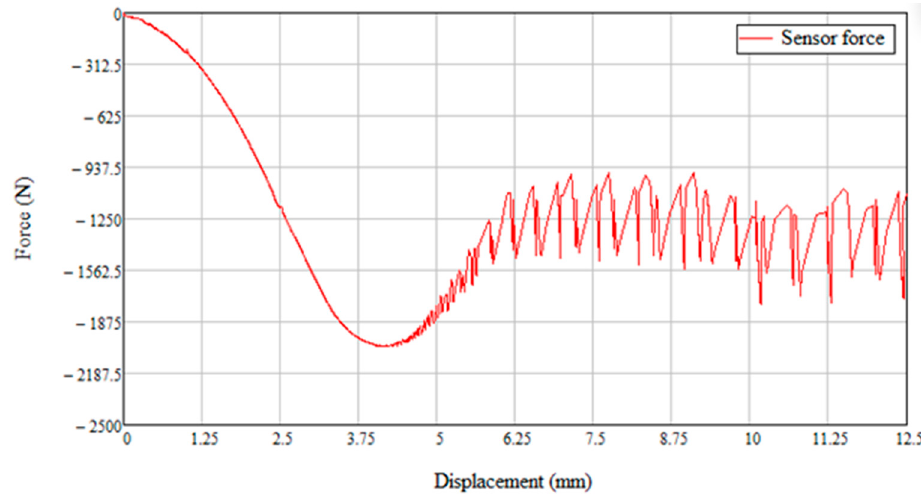
Figure 9. Axial force measured by the force sensor as a function of the displacement of the cover for the oil-free assembly case.